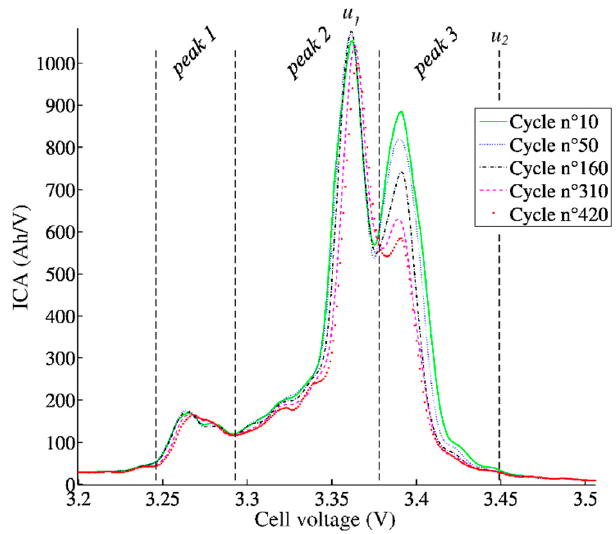
Figure 4. IC curves evolution during the cycling accelerated ageing (C/3 and 50 °C).